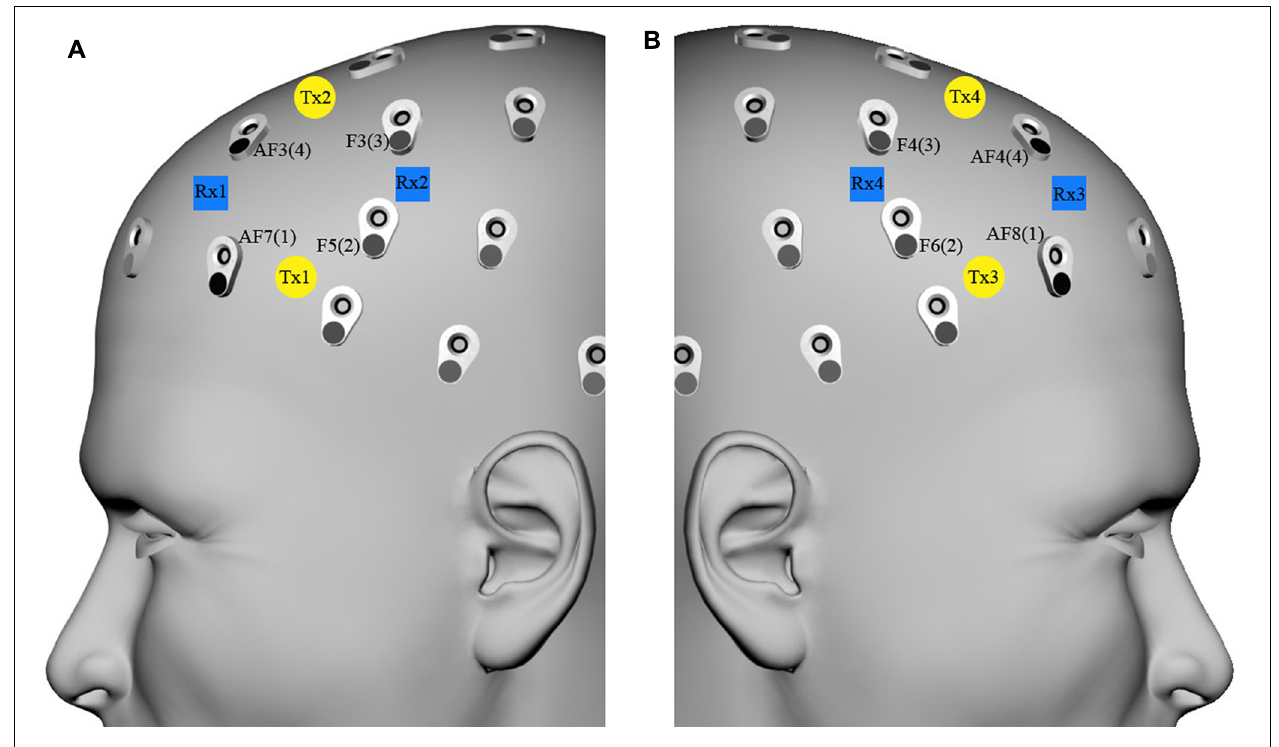
FIGURE 2 | fNIRS optode localization on the forehead scalp region overlying the dorsal part of the prefrontal cortex. fNIRS transmitters [ (A) Tx1–Tx2, (B) Tx3–Tx4, yellow circles) and receivers [ (A) Rx1–Rx2, (B) Rx3–Rx4,